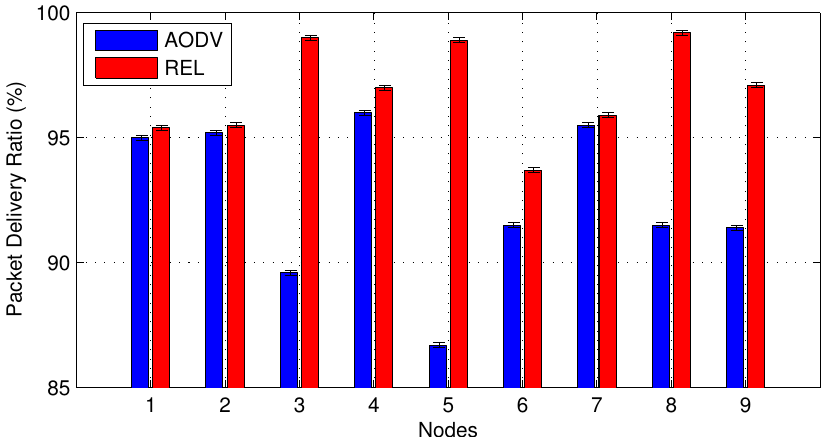
Figure 6. Packet delivery ratio in testbed